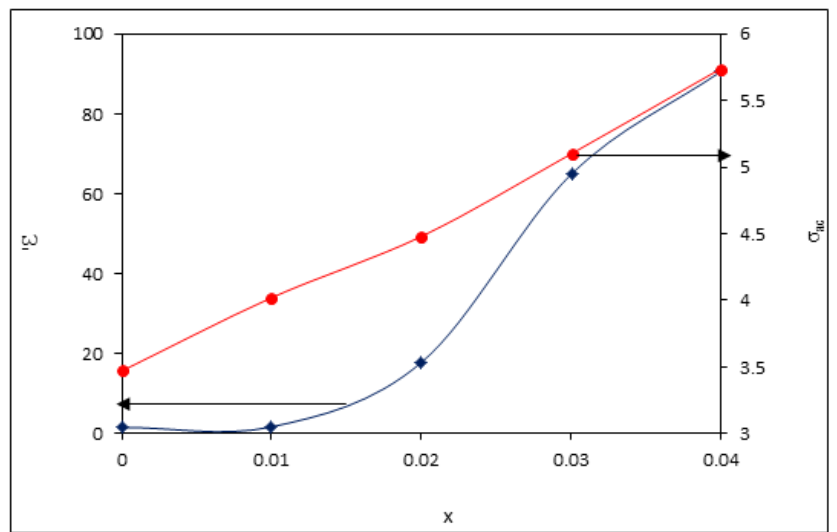
Fig. 9: The dielectric constant and a. c. conductivity as a function of concentration for Ni Zn Li Fe O {where x= 0, 0.01, 0.02, 0.03, 0.04}. 0.9-2x 0.1 x 2+x 4 Table 2: Dielectric properties (capacitance (C), dissipation factor (D), dielectric constant (Ԑ') and ac conductivity (σ ) as a function of composition at frequency 5×10 5 Hz. ac x C(F)×10 -12 D